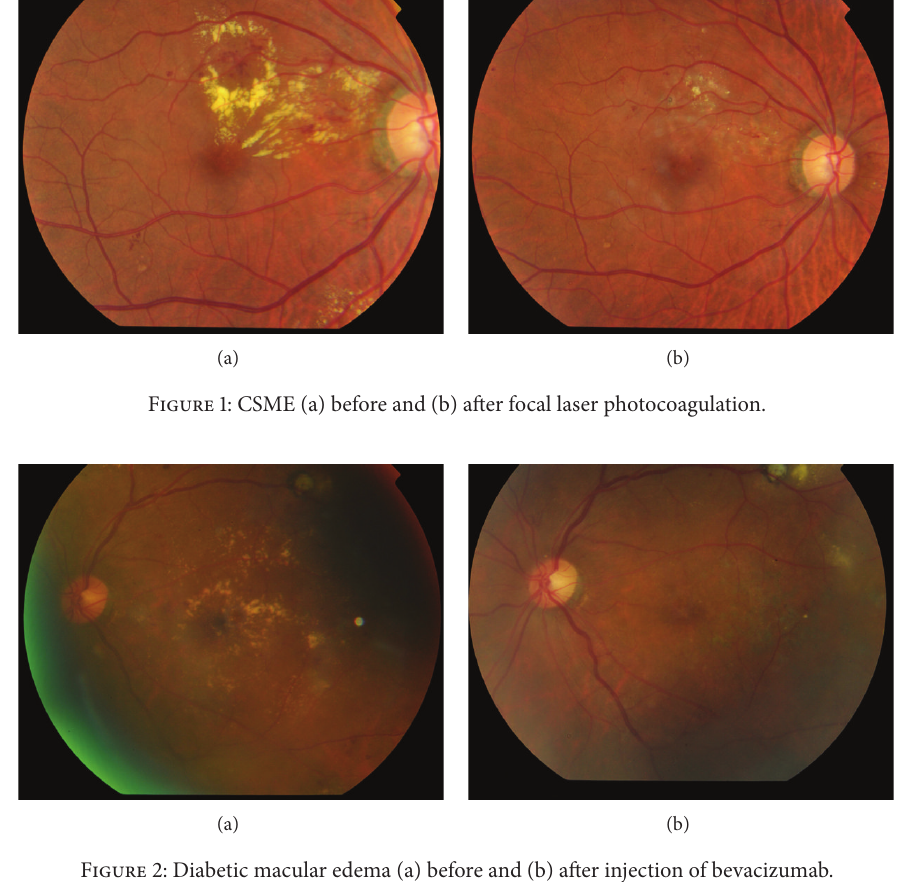
Figure 2: Diabetic macular edema (a) before and (b) after injection of